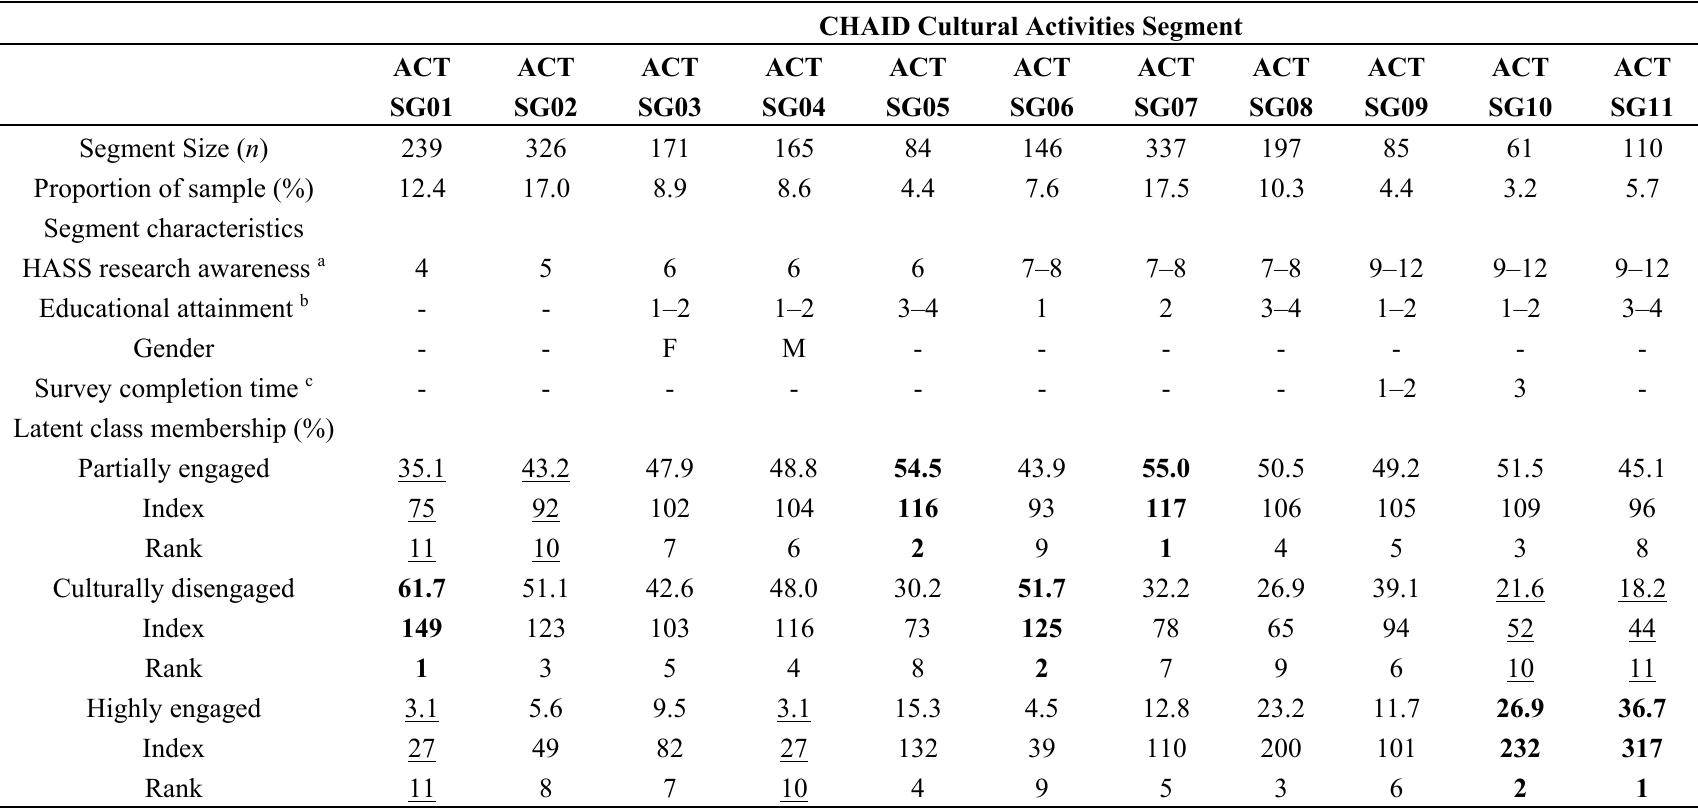
Table 6. Summary of CHAID segmentation of activity-based latent class